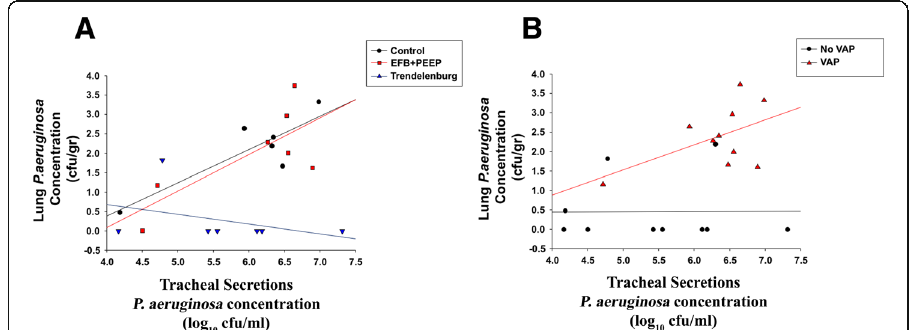
Fig. 4 Lung P . aeruginosa burden as a function of tracheal secretions P . aeruginosa burden. a The linear regression equation was fitted to predict lung P . aeruginosa burden by tracheal secretions P . aeruginosa burden (log10 cfu/mL) and clustered by study groups. Regression equation control group: [lung P . aeruginosa burden (log 10 cfu/g)= − 3.06 + (0.85 × tracheal secretions P . aeruginosa burden (log 10 cfu/mL)]. N =6, R =0.85, R 2 =0.73, Adjusted R sqr =0.67, p value = 0.029. Regression equation EFB + PEEP group: [lung P . aeruginosa burden (log 10 cfu/g)= − 3.68+(0.94 × tracheal secretions P . aeruginosa burden (log 10 cfu/mL)]. N =7, R =0.76, R 2 =0.57, Adjusted R sqr =0.49, p value = 0.048. Regression equation Trendelenburg group: [lung P . aeruginosa burden (log 10 cfu/g)= − 1.67 + ( − 0.25 × tracheal secretions P . aeruginosa burden (log 10 cfu/mL)]. N =7, R =0.37, R 2 =0.14, Adjusted R sqr =0.00, p value = 0.411. b The linear regression equation was fitted to predict lung P . aeruginosa burden by tracheal secretions P . aeruginosa burden (log10 cfu/mL) and clustered by development of ventilator-associated pneumonia (VAP). Regression equation VAP: [lung P . aeruginosa burden (log 10 cfu/g)= − 1.69+(0.64 × tracheal secretions P . aeruginosa burden (log 10 cfu/mL)]. N =10, R =0.51, R 2 =0.26, Adjusted R sqr =0.17, p value = 0.130. Regression equation no VAP: [lung P . aeruginosa burden (log 10 cfu/g)=0.41 + (0.007 × tracheal secretions P . aeruginosa burden (log 10 cfu/mL)]. N =10, R =0.01, R 2 =0.00, Adjusted R sqr =0.00, p value = 0.980. EFB + PEEP expiratory flow bias and positive end expiratory pressure